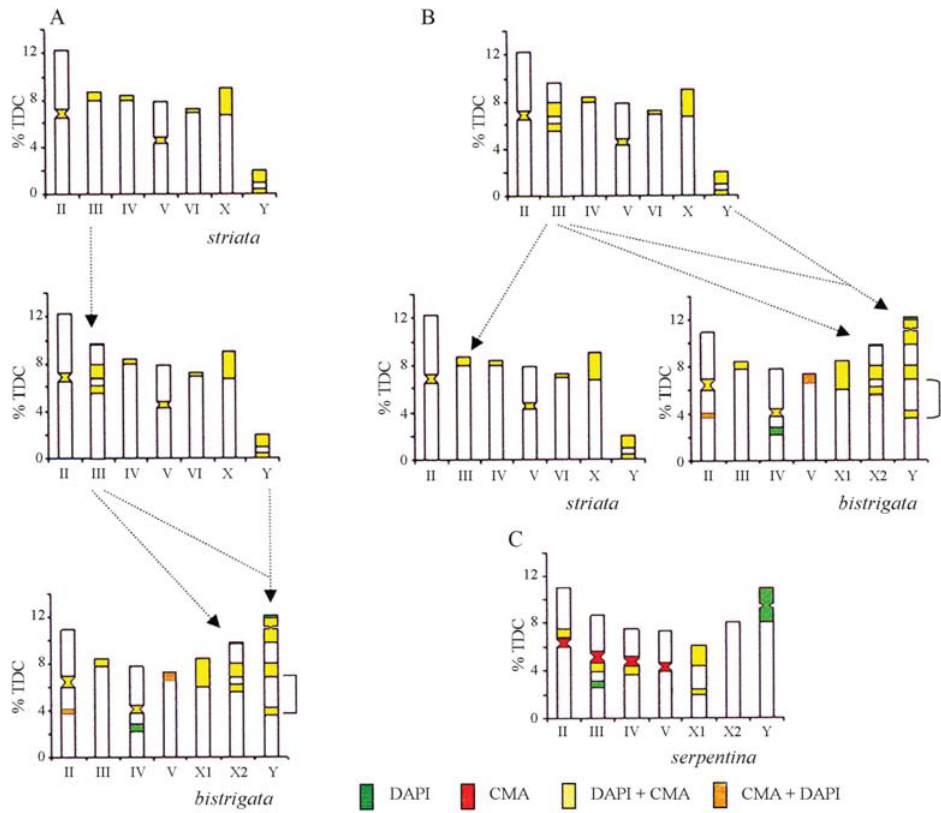
Figure 3 - Idiograms of the mitotic chromosomes of Anastrepha striata , A . bistrigata and A. serpentina , in which the heterochromatic blocks are marked by position, size and affinity for the fluorochromes DAPI and CMA 3 . Positions of centromeres are indicated by indentation, and in acrocentric chromo- somesthecentromereisonthetop.ColorcodesasinFigure1.(A)AutosomeIIIof A.striata wasproposedasthechromosomeinvolvedintheY:Afusion, originating the neo-X/neo-Y chromosomes of A. bistrigata . In the diagram on the left (A), the original karyotype was that of A. striata (top diagram) , and an inversion in autosome III originated a hypothetical karyotype (middle diagram) from which the A. bistrigata karyotype derived by fusion of autosome III to the Y chromosome (bottom diagram). On the right (B), it is proposed that the karyotypes of A. striata and A bistrigata derived independently from a hypothetical karyotype, considering the same events as in the previous diagram (A). The bracket on the side of the long arm of the A. bistrigata neo-Y chromosome indicates the suggested inversion separating the two heterochromatic blocks. In (C), the idiogram of A. serpentina shows the greatest differ- ences in affinity of the heterochromatic block to the fluorochromes in relation to the chromosomes of A. bistrigata and A.